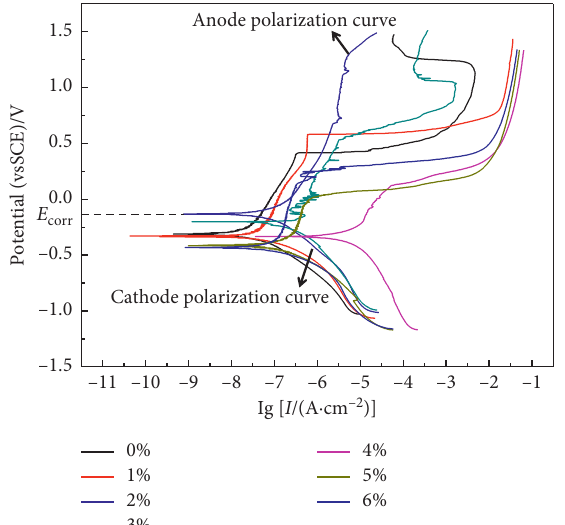
Figure 9: Bode plot of the laser-cladding coatings with different CeO 2 contents in 3.5% NaCl